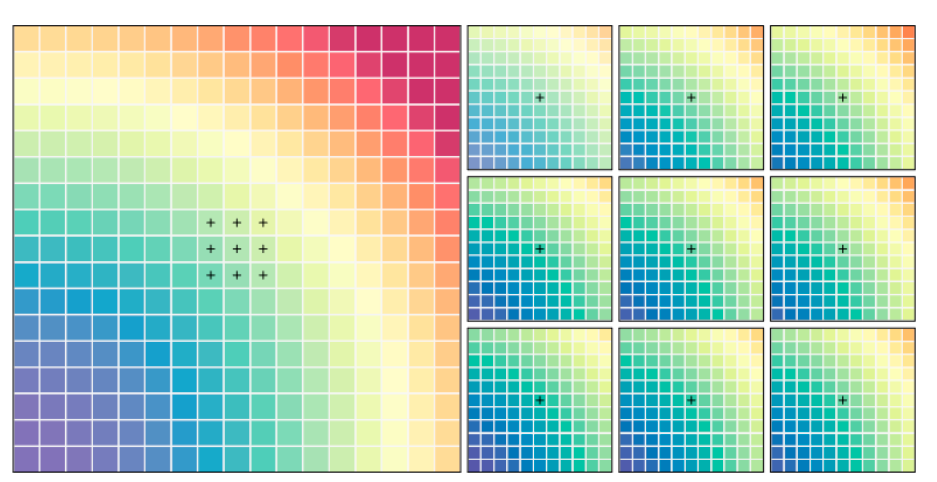
Figure 1. Illustrating 5-order shape of the extent of spatial correlation